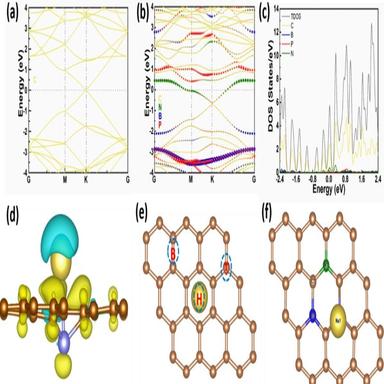
Electronic band structure of the pristine (a) and N, B, and P tri-doped carbon (b). (c) Density of states of N, B, and P tri-doped carbon. (d)The charge density difference, where the yellow and cyan color represents the charge accumulations and depletion, respectively. (e) Top views of the pure carbon materials, with three possible Na adsorption sites (H, B, and T) labeled, and (f) tri-doped carbon material.